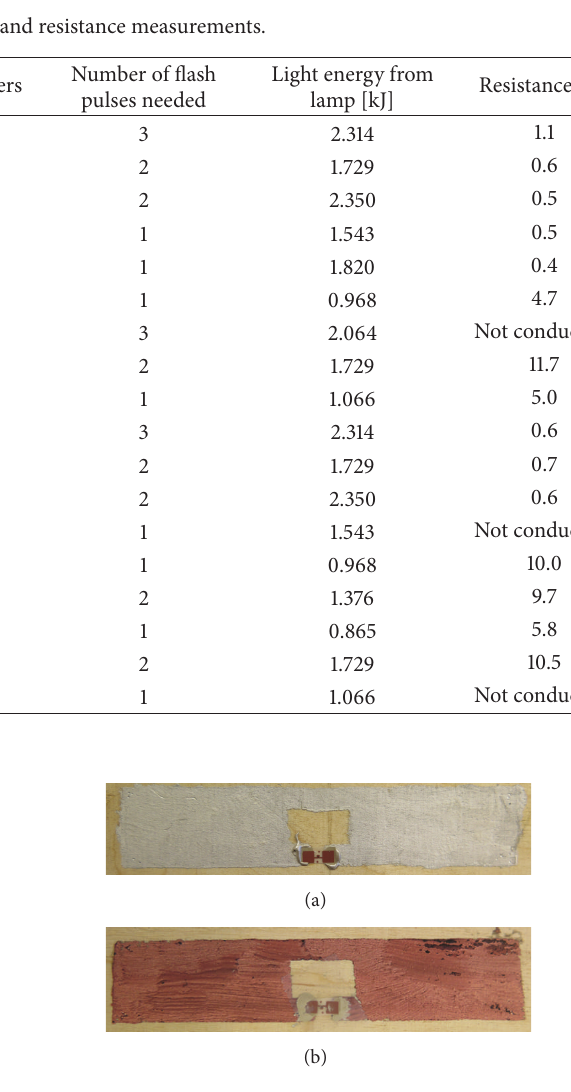
Figure 3: (a) Sample 4, a silver antenna on wood substrate, and (b) Sample 9, a copper antenna on wood